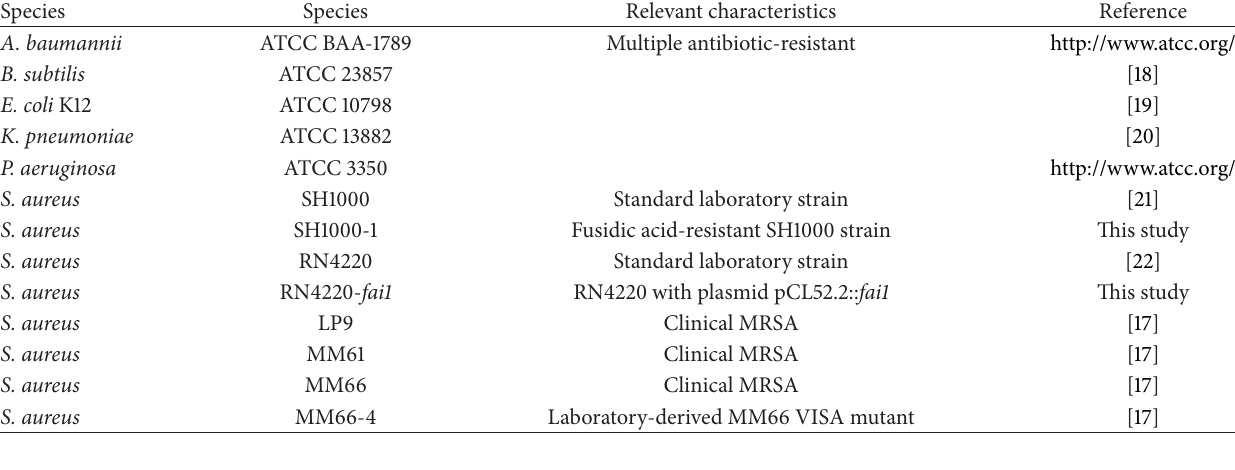
Table 1: Bacterial species and strains utilized in this study.